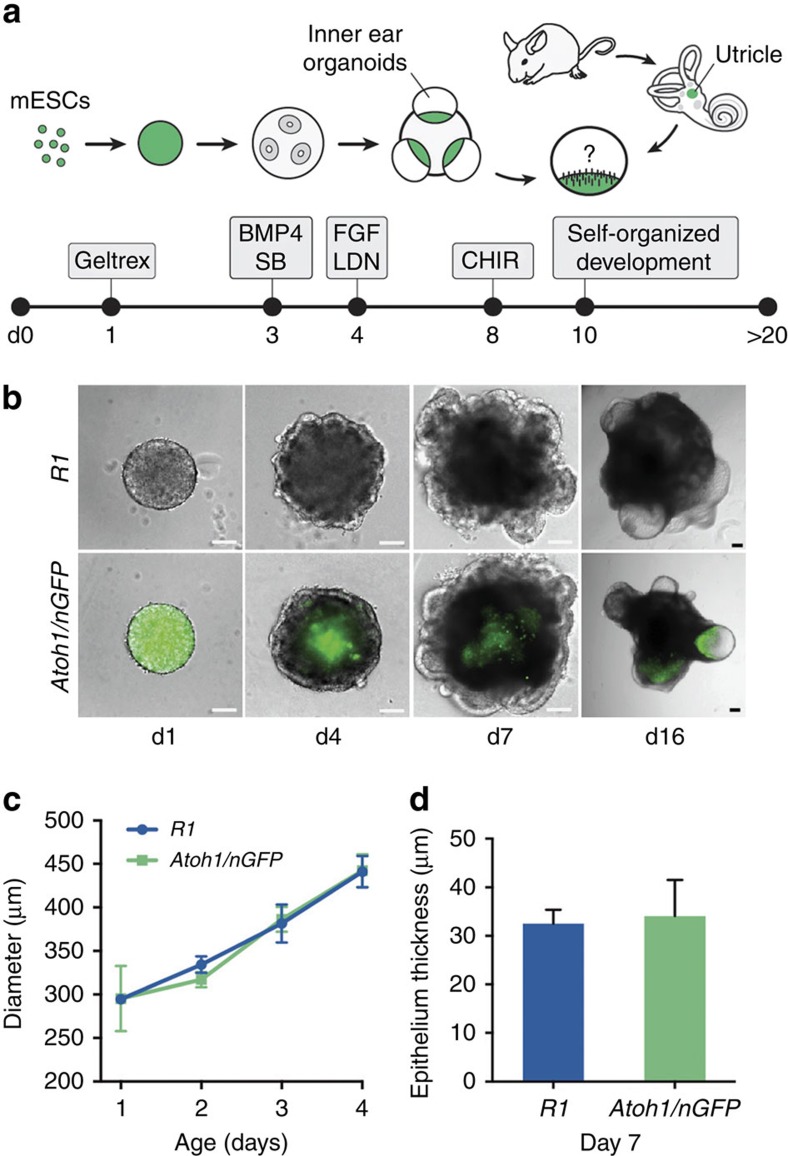
Generation of inner ear organoids from R1 and Atoh1/nGFP ES cells.(a) Schematic overview of the inner ear induction protocol. (b) Comparison of aggregate morphology during otic induction in R1 and Atoh1/nGFP cells. Scale bars, 100 μm. Inner ear organoids can be seen protruding from the aggregates in the day 16 panels. (c) The mean (±s.e.m.) diameter of R1 and Atoh1/nGFP cell aggregates increases at a similar rate over time. (d) The mean (±s.e.m.) apparent thickness of outer epithelia on day 7 aggregates is not significantly different between R1 and Atoh1/nGFP aggregates.